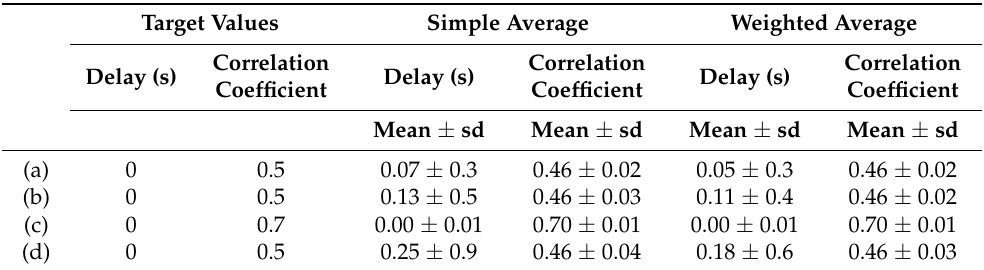
Table 5. Maximum correlation coefficients and corresponding time shifts estimated at group level for simulated data. Both the simple and the weighted average results are shown.